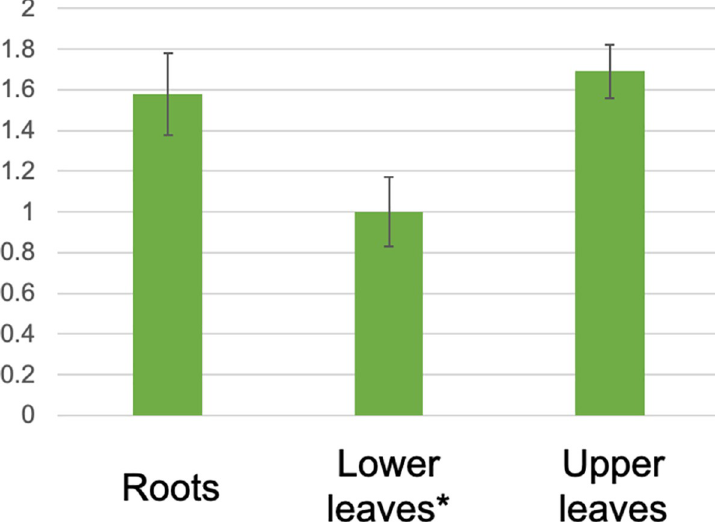
Fig 3. Gene expression analysis for As BGNL. The expression levels are normalised with that of lower leaves, which is indicated with an asterisk ( � ). Black lines stand for standard deviation.